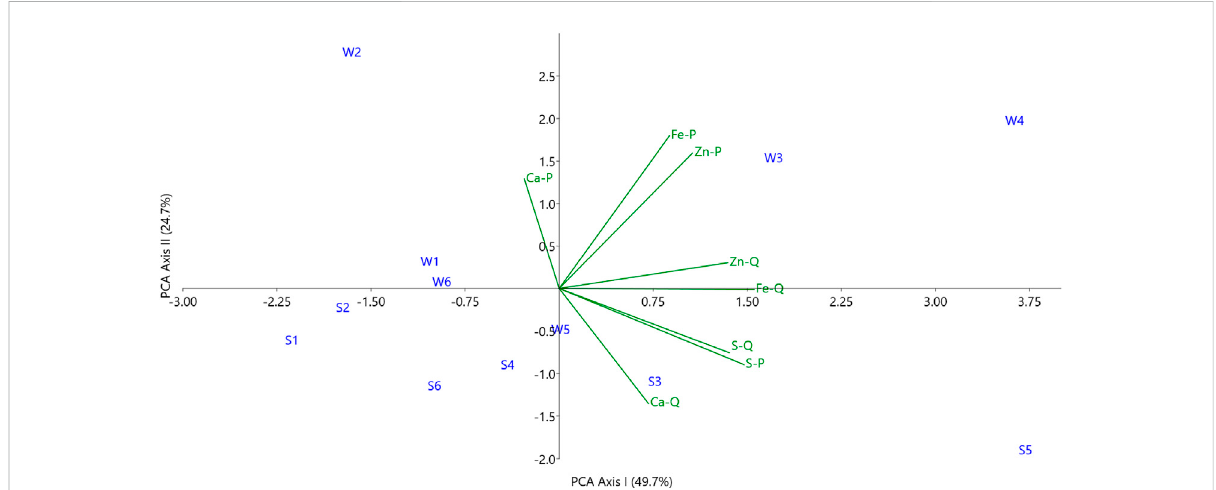
FIGURE 4 Two-dimensionalPrincipalComponent Analysis (PCA) for the6winter (W)and 6spring-summer(S) samples. The input variables are theCa, Fe, S, and Zn concentrations determined by PIXE using both PTFE (P) and quartz (Q) fi lters. The percentages of the total variance explained by the fi rst and second principal component are also indicated in the plot.